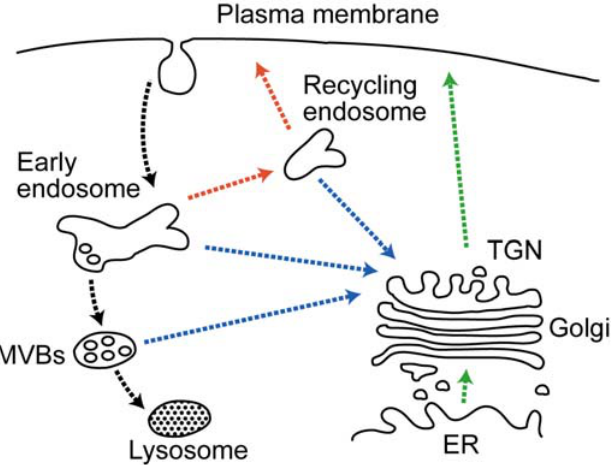
Figure 4. Schematic diagram of the organization of organelles and the intracellular transport pathways. The major membrane-bound organelles and the main routes of protein transport are indicated, with the secretory pathway in green, the endocytic degradation pathway in black, the recycling pathway in red and the retrograde pathway in